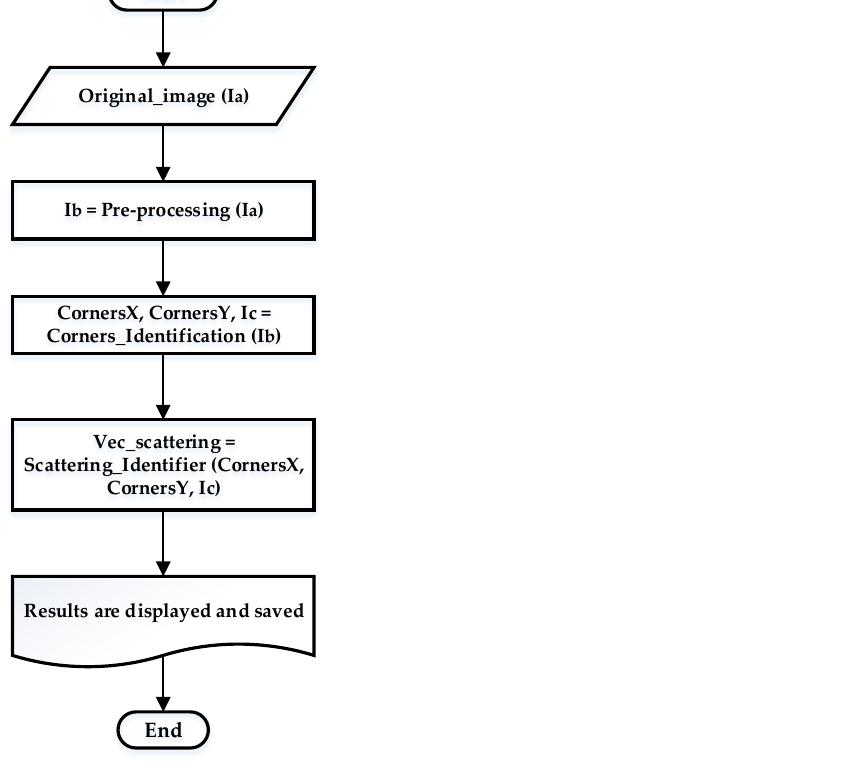
Figure 3. Flow chart of the proposed method for the automatic calculation of mixing